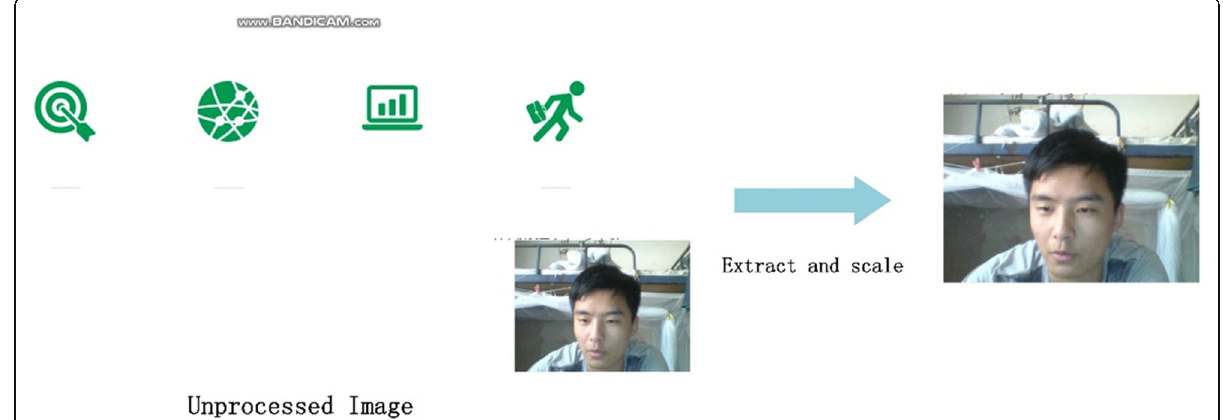
Fig. 5 Image pre-processing